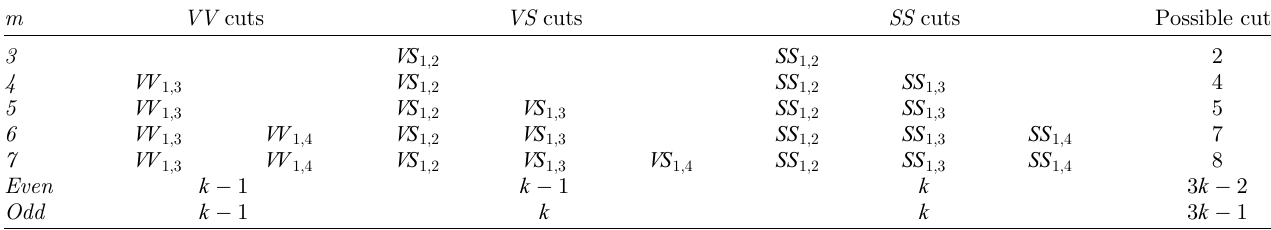
Table 1. Possible cuts for m -polygons m ¼ 3 ; 4 ; ... ; 7 and the general